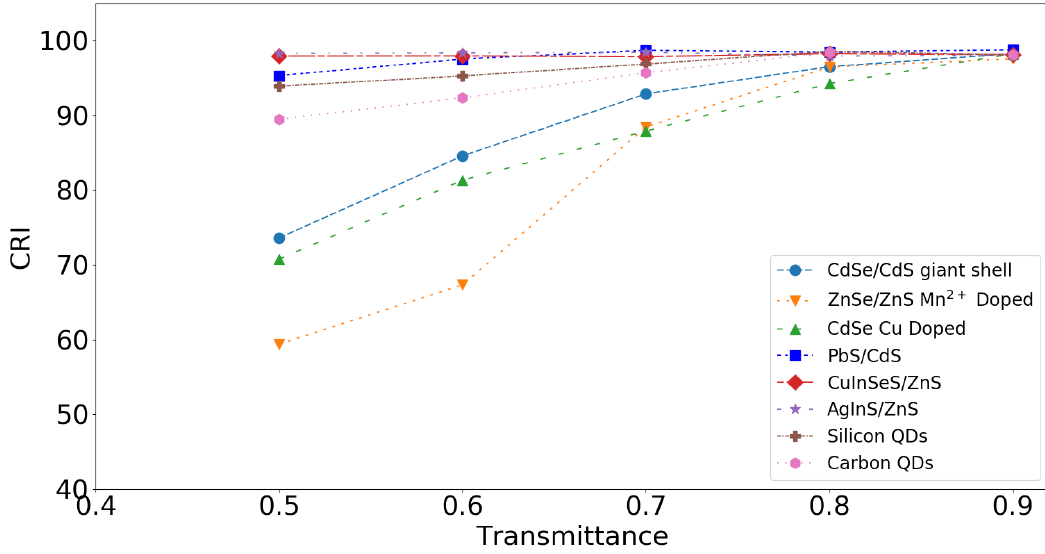
Figure 11. Color rendering index (CRI), plotted against T vis